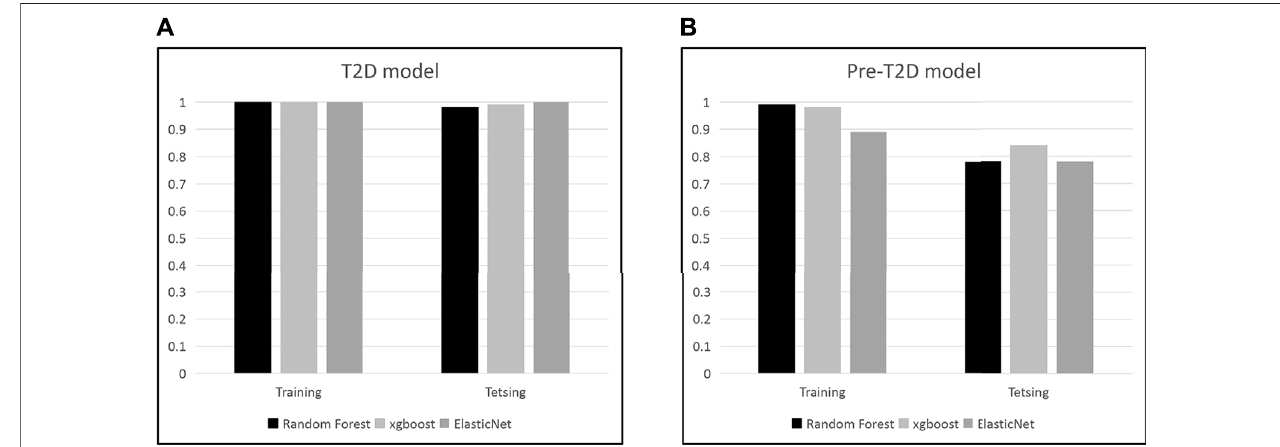
FIGURE 5 | Development of T2DM and Pre-T2DM models with different machine learning approaches.